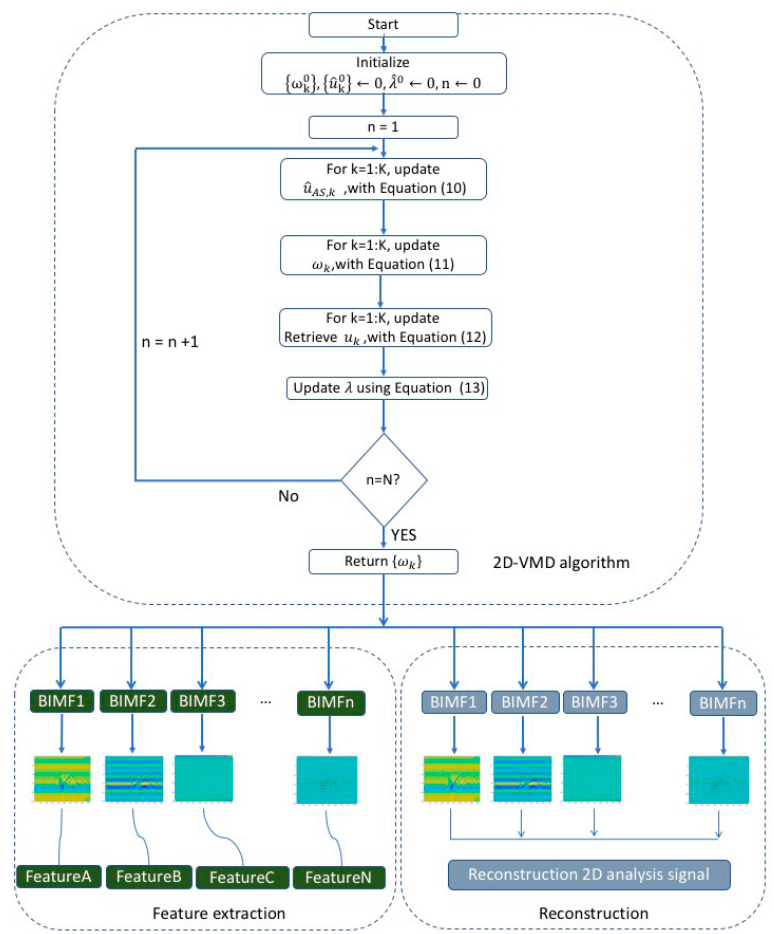
Figure 1. The schematic diagram of feature extraction and reconstruction model framework of human motion 2D echo signal based on two-dimensional variational mode decomposition (2D-VMD) algorithm by carrier-free ultra-wideband (UWB) radar in our paper.